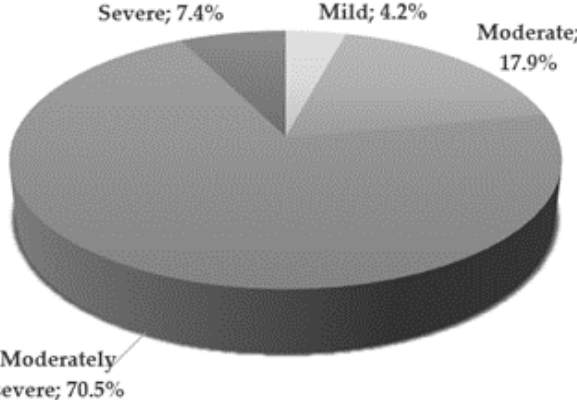
Figure 1. Severity of depression in the study group according to HDRS score criteria; Mild—8–12; Moderate—13–17; Moderately severe—18–29; Severe— ≥ 30 points.